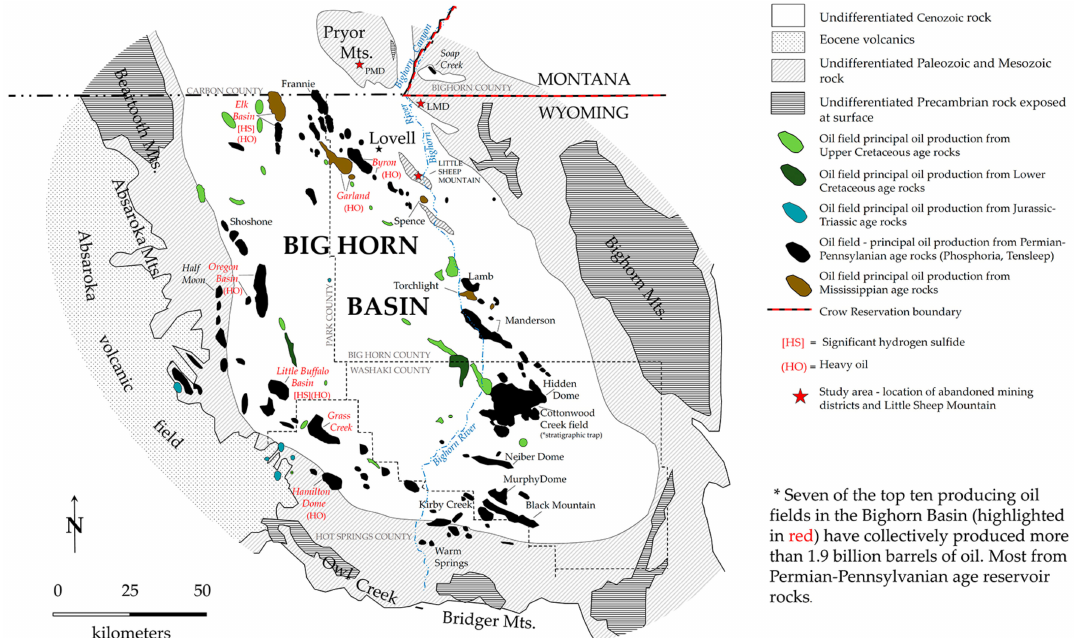
Figure 12. Map showing approximate location of some of the main oilfields in the Bighorn Basin. The study areas are shown by the red stars. Oil field locations and reservoir rock designation are modified from the Wyoming State Geological Survey’s Wyoming Oil and Gas Field map, 2016 [82]. Figure modified from Wyoming State Geological Survey